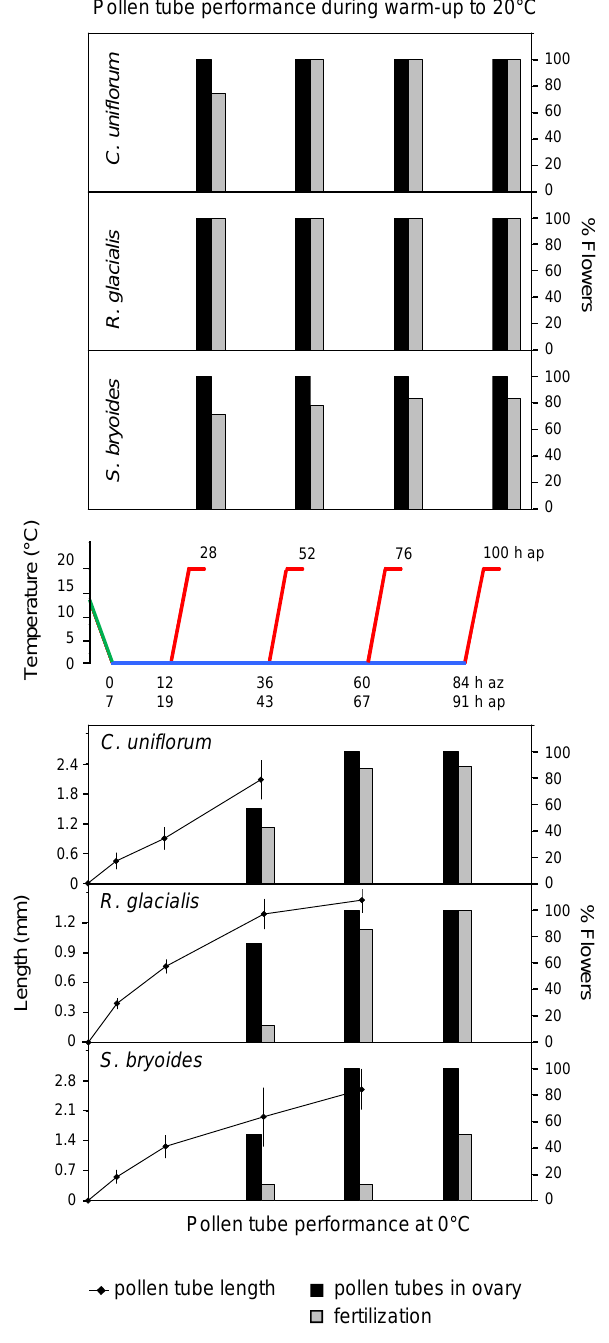
Figure 2. Performance of nival species during the simulation of a cold snap in the laboratory. For further details see Figure